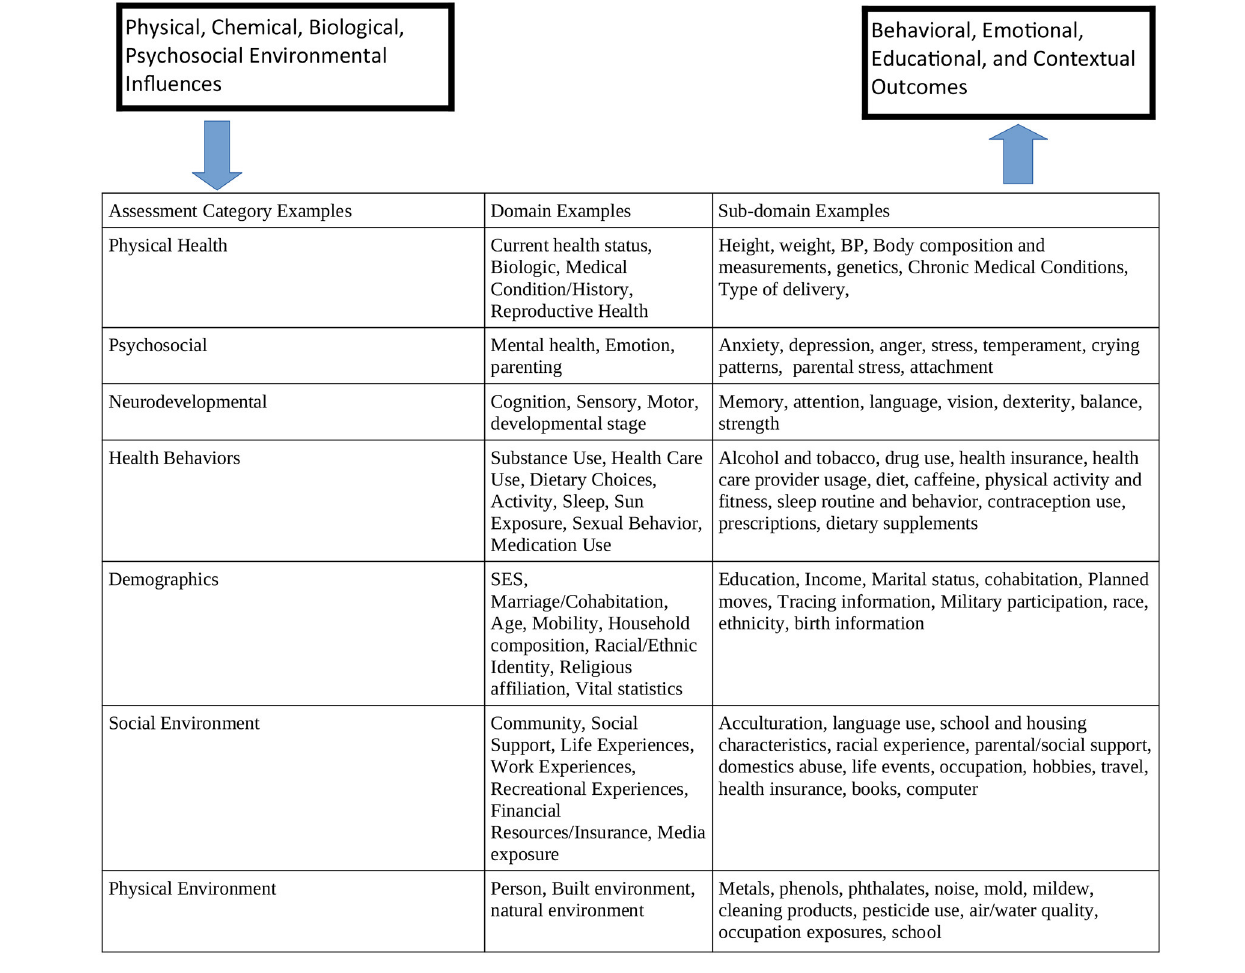
FIGURE 2 | Relationship of NCS scientific goals to measurement domains. The scientific goals are summarized in the box on the upper right and the mandated outcomes are on the box on the upper left. In the middle table are examples of assessment domains with examples of sub domains that map to specific